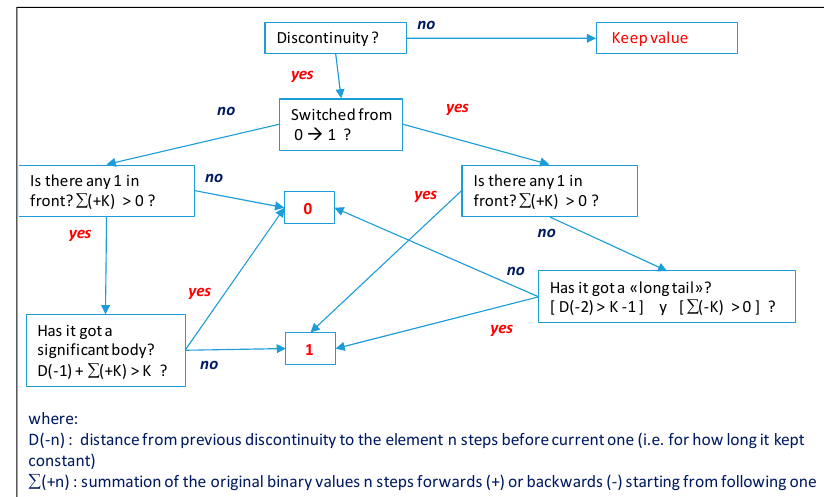
Figure 8. The logical heuristic, binary attribute, Holistic algorithm implemented for the Magdalena River. Notice that this figure—for simplicity- does not represent the full algorithm, but the essence of its logics and as such the intermediate variables Holistic 1, 2, 3 are not identifiable, nor is the role of the threshold α .